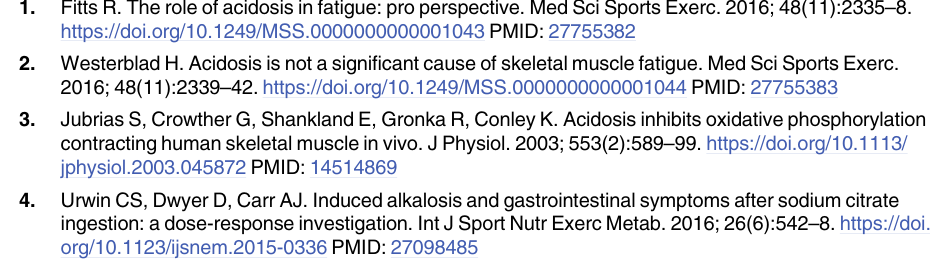
S4 Table. Pairwise comparisons (mean difference, 95% CI) of palatability ( n = 16 partici- pants) and urinary excretion values ( n = 8 participants) following ingestion of 500 mg.kg -1 BM sodium citrate over 15, 30, 45 or 60